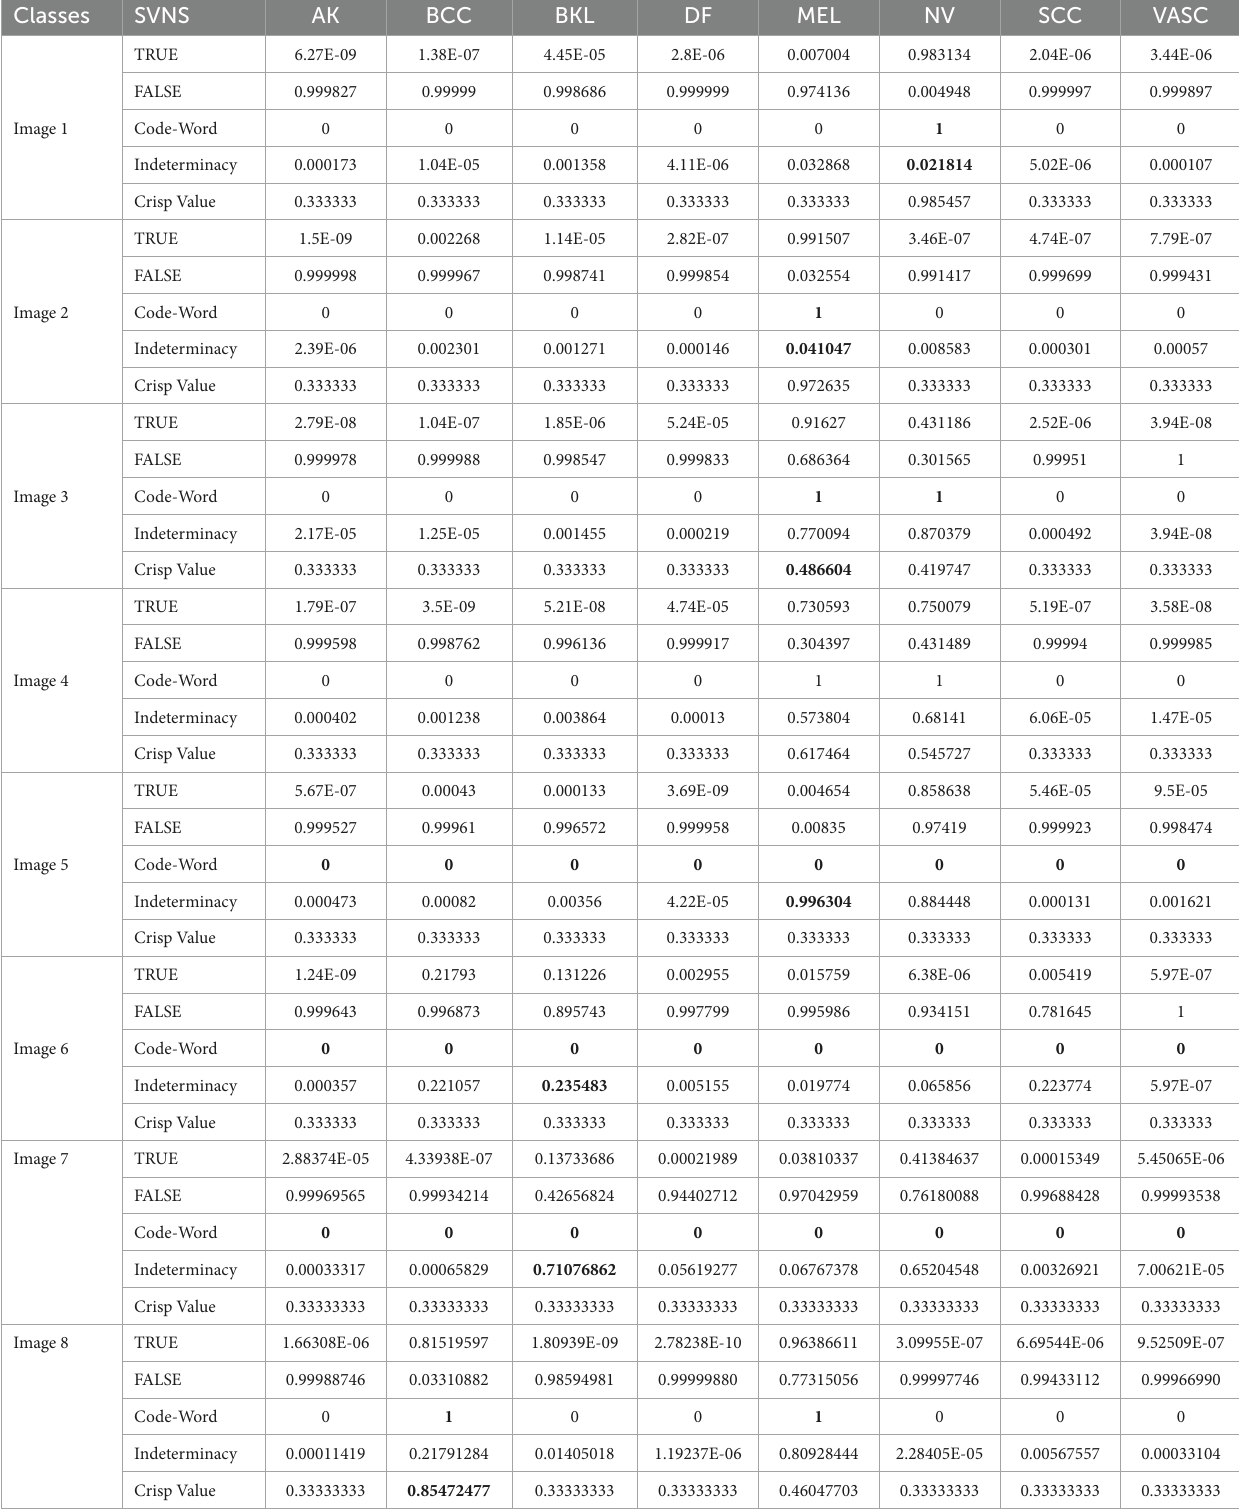
TABLE 4 Single-valued neutrosophic